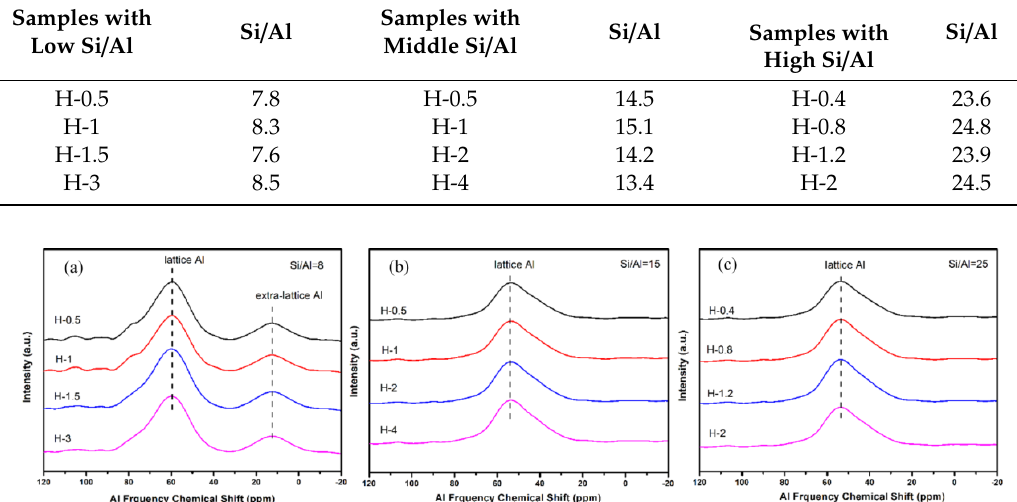
Table 5. Si/Al ratios for the obtained SSZ-13s with Si/Al = 8, 15, and 25. Samples with Low Si/Al Si/Al Samples with Middle Si/Al Si/Al Samples with High Si/Al Table 5. Si / Al ratios for the obtained SSZ-13s with Si / Al = 8, 15, and 25. Samples with